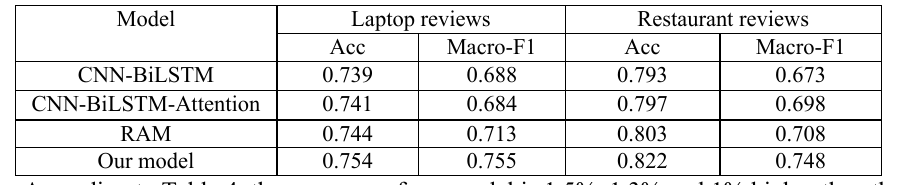
Table 4. Experimental results.